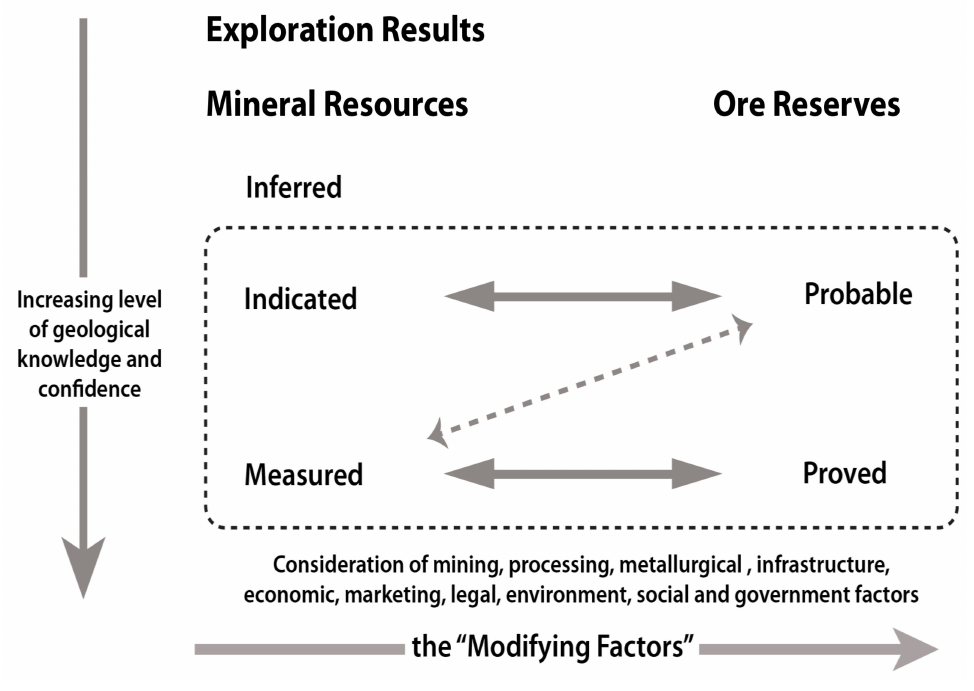
Figure 7. The relationship between Exploration Results, Mineral Resources, and Ore Reserves